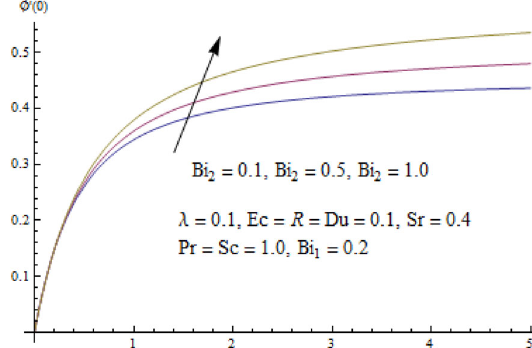
Fig. 31 Impact of Bi 2 on φ (cid:5) ( 0 )